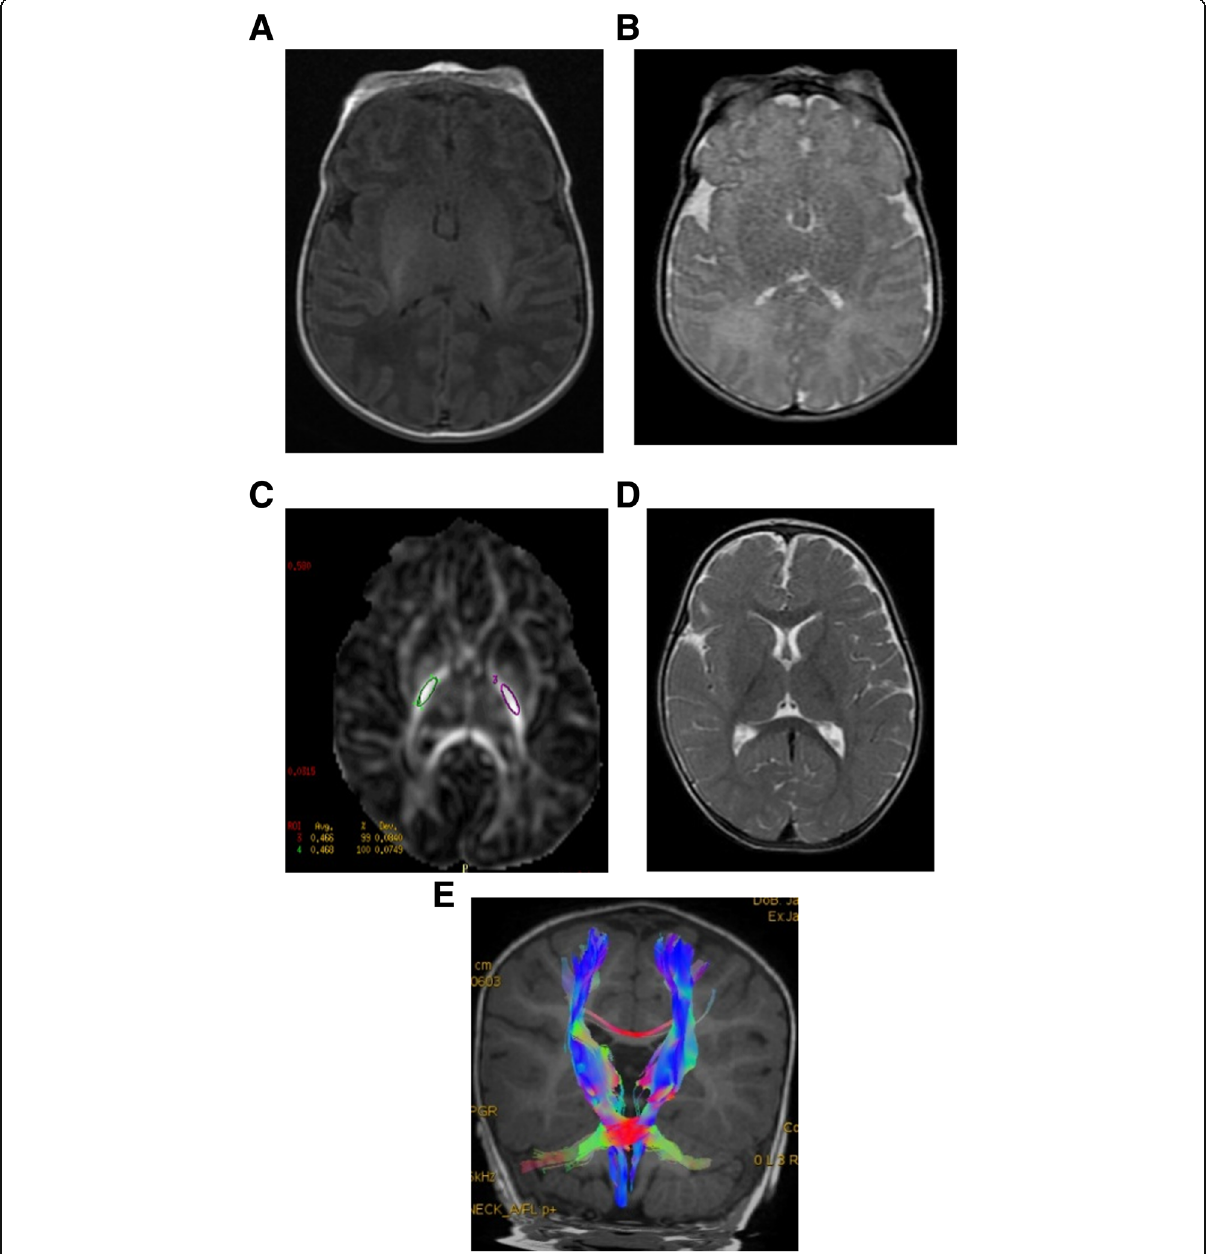
Fig. 2 Ten days neonate presenting with moderate HIE picture, Sarnat II with normal final outcome. Conventional MRI: a , b axial T1 and T2 showed preserved PLIC signal and distinct gray-white matter differentiation. DTI: c posterior limb of internal capsule FA value = 0.47. Follow-up examination: d axial T2 is unremarkable, and e tractography showed preserved integrity of the corticospinal